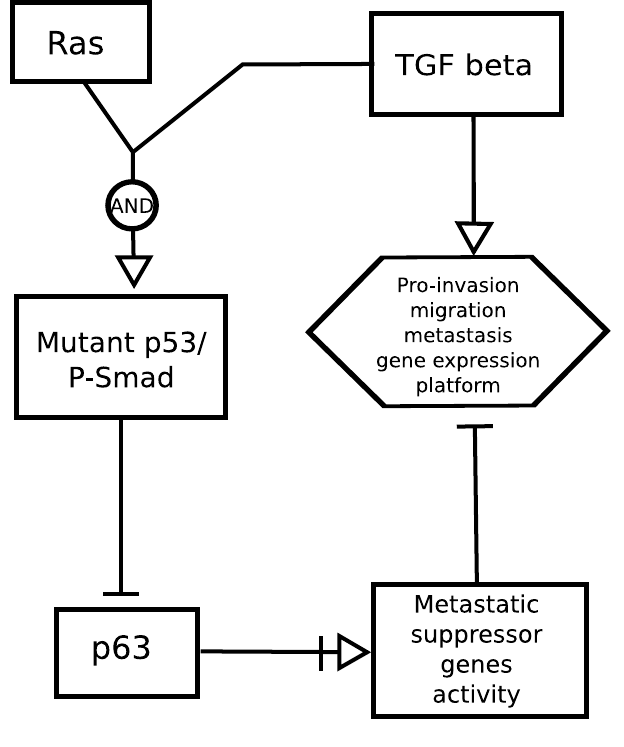
Figure A.1: Regulation of TGF β -induced